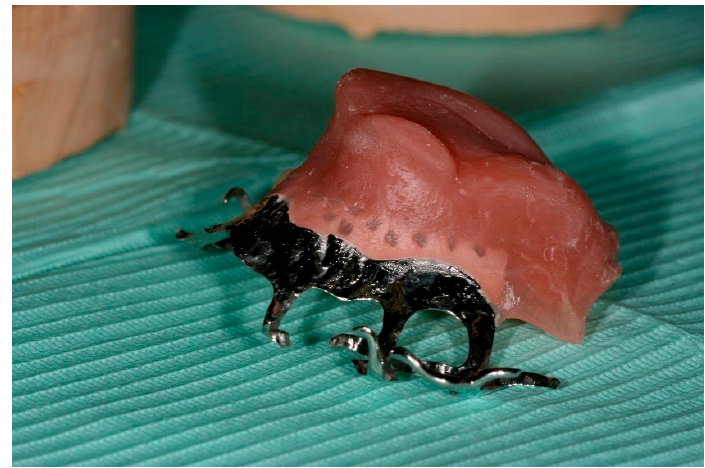
Figure 1. A palatal obturator.